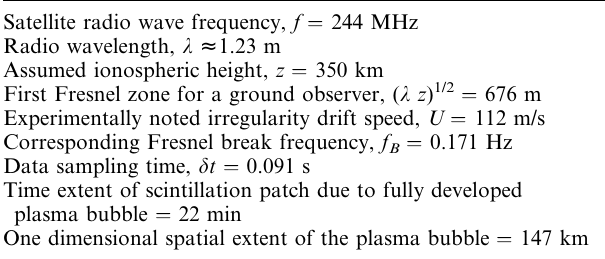
Table 1. Numerical values of some physical parameters Satellite radio wave frequency, f (cid:136) 244 MHz Radio wavelength, (cid:107) » 1.23 m Assumed ionospheric height, z (cid:136) 350 km First Fresnel zone for a ground observer, ( (cid:107) z ) 1/2 (cid:136) 676